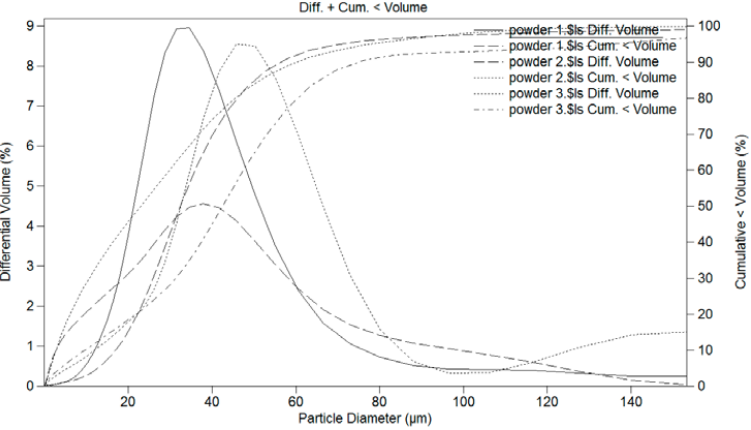
Figure 1. Particle size distribution of powders 1, 2, and 3.